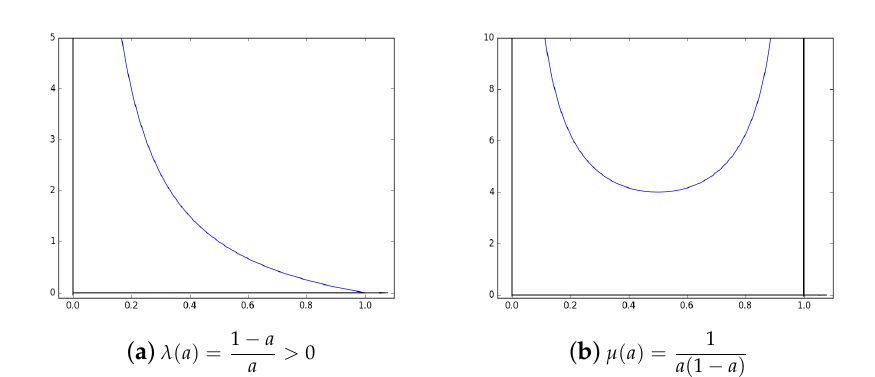
Figure 2. Parameter dependence against a ∈ ] 0,1 [ .